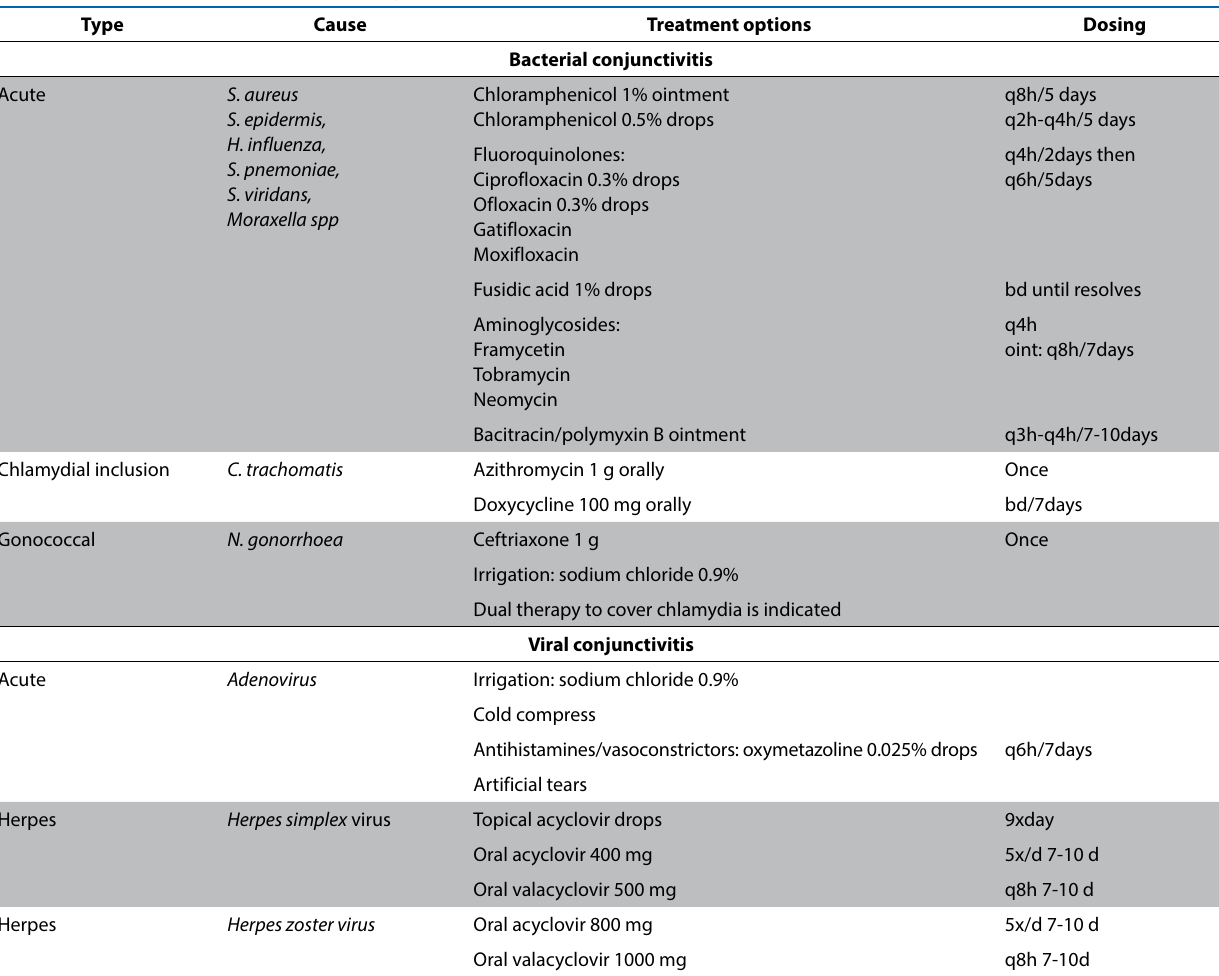
Table 4: Ophthalmic therapies for infectious conjunctivitis 4,6,28,29,34-36,37-42